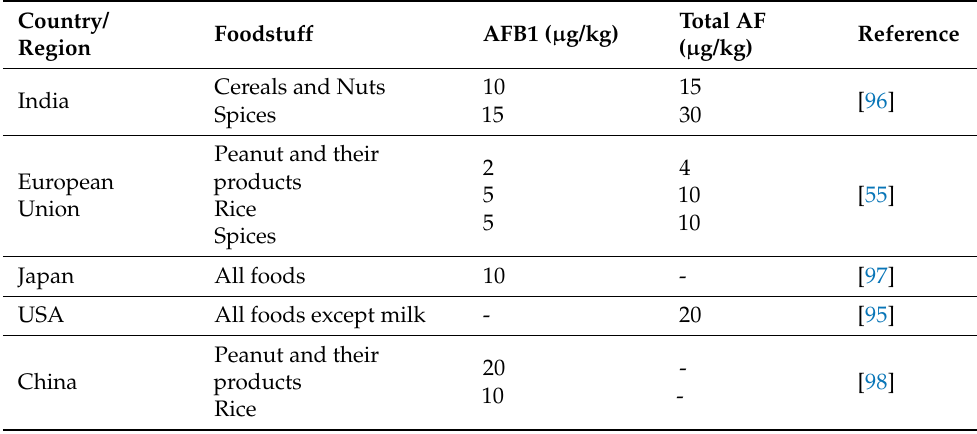
Table 3. MLs of AFs (B1 and Total) in various food commodities traded from India and major trading